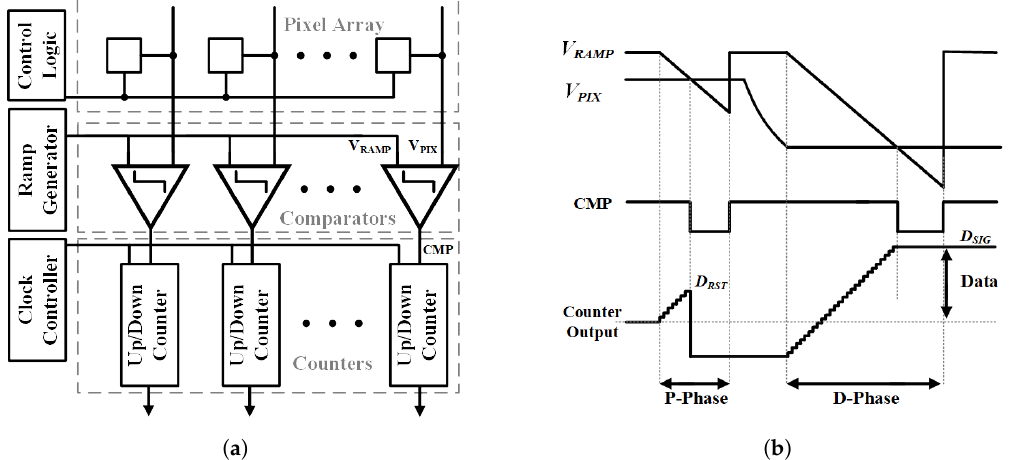
Figure 1. Block diagram of a CIS system.